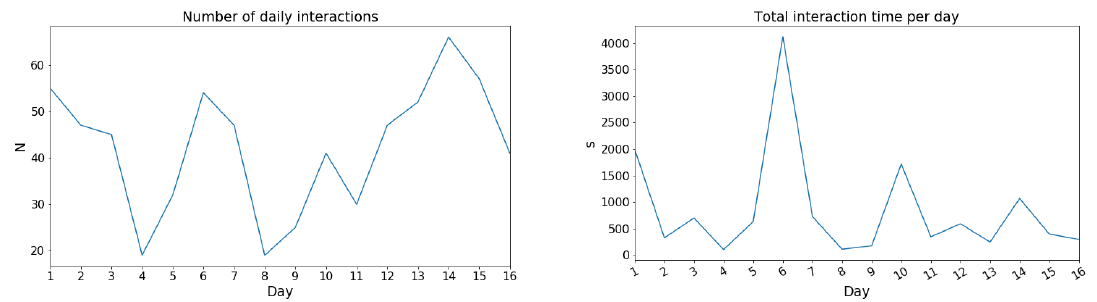
Figure 3. Daily variations in the tunnel prototype